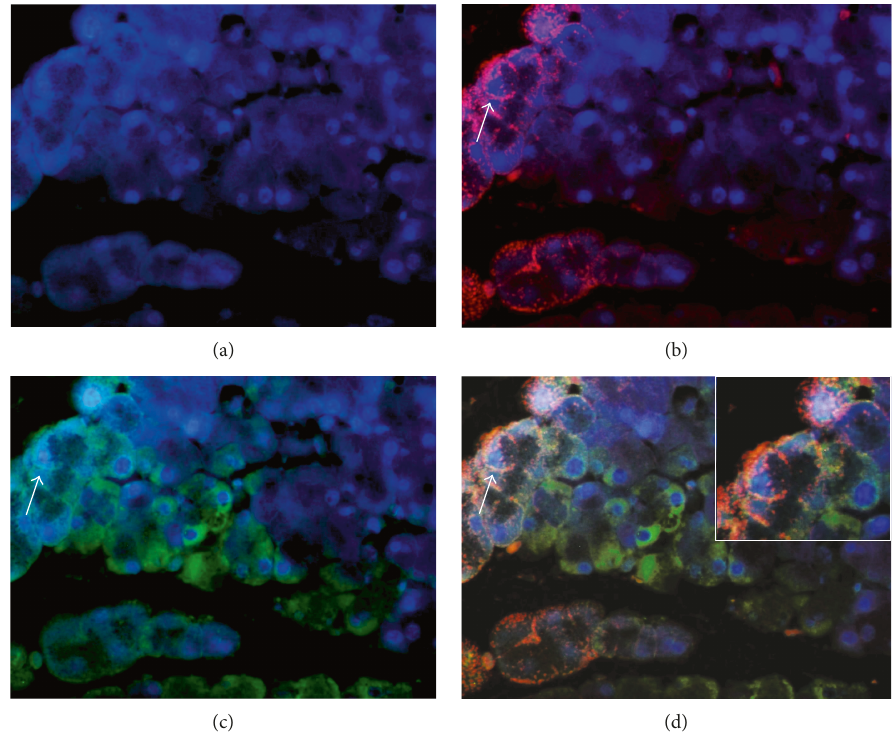
Figure 9: The translocation of Ro60 ribonucleoproteins onto apoptotic membranes as shown in the Annexin assay. (a) Nuclear staining in blue by DAPI. (b) Ro60 stained in red. (c) Apoptotic membranes (green). (d) Arrows correspond to the overlapping image of Annexin (green) with Ro60 (red) in orange (enlarged image in